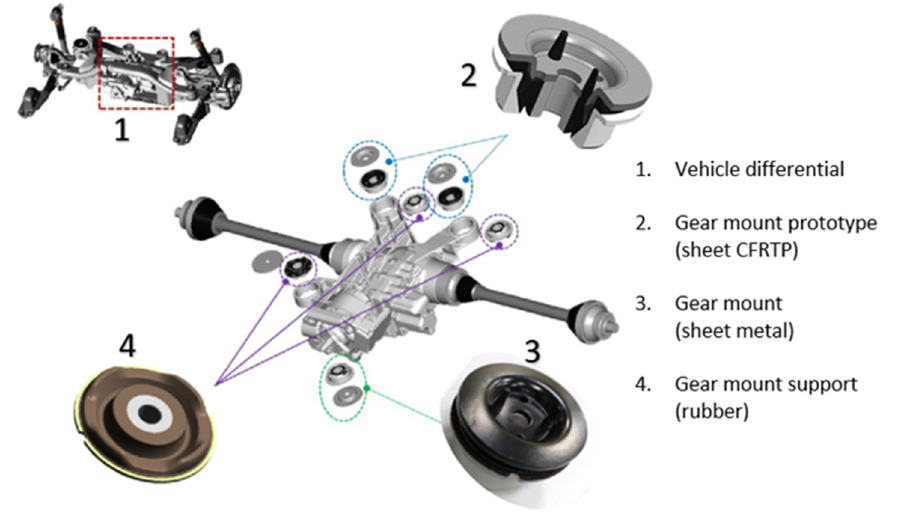
Figure 8. Vehicle Differential System.